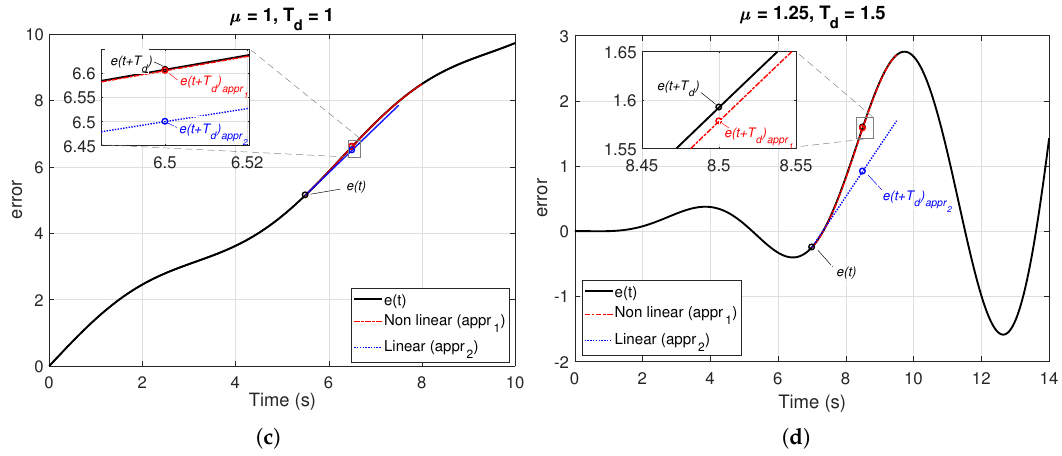
Figure A1. Prediction horizons of derivative part depending on the order µ : ( a ) µ = 0.4, T d = 2 ( b ) µ = 0.8, T d = 1 ( c ) µ = 1, T d = 1 ( d ) µ = 1.25, T d = 1.5. Notice that cases ( a ) and ( c ) correspond to the error as the function e ( t ) = t + 0.5sin ( t ) , whereas the error is given by e ( t ) = 0.01 t 2 ( 1 in cases ( b ) and ( d